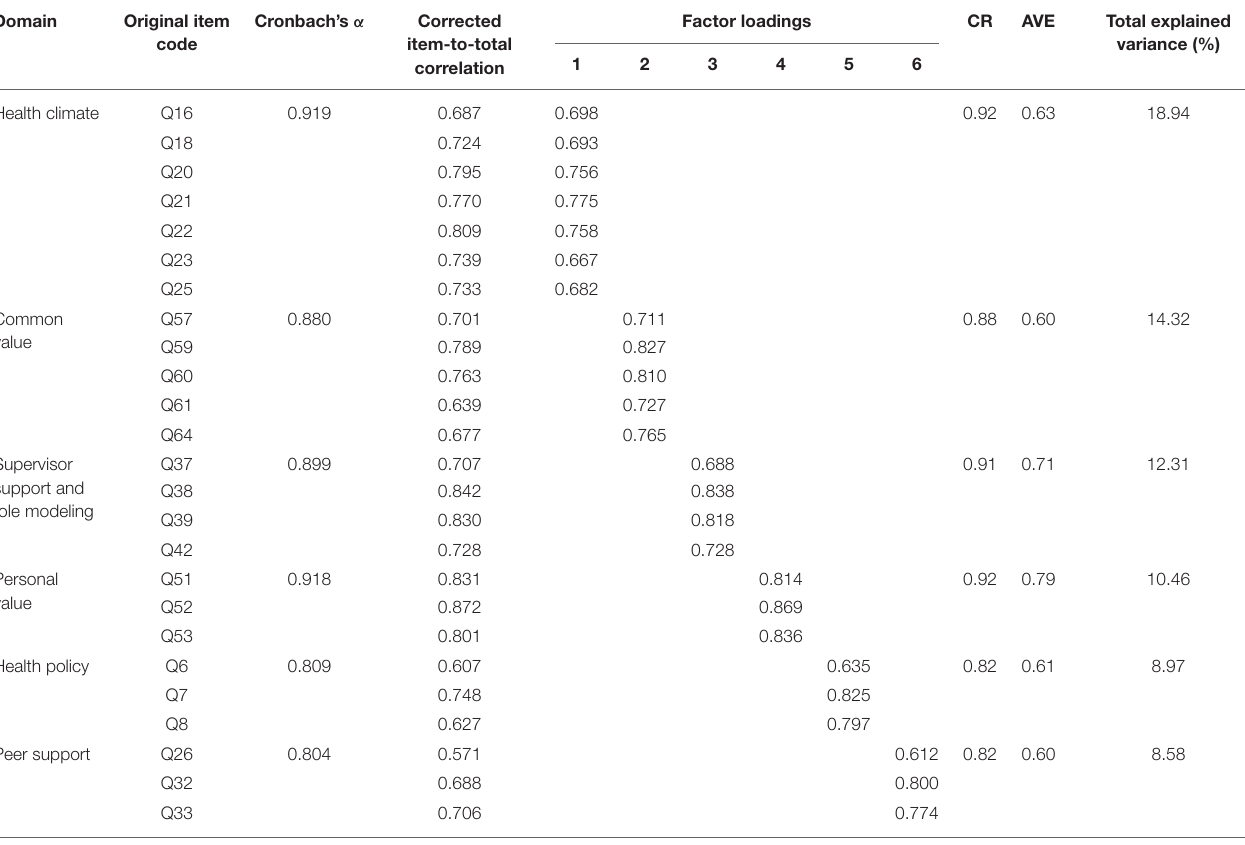
TABLE 3 | Factor loadings for 25-items workplace health culture scale ( N = 650). Domain